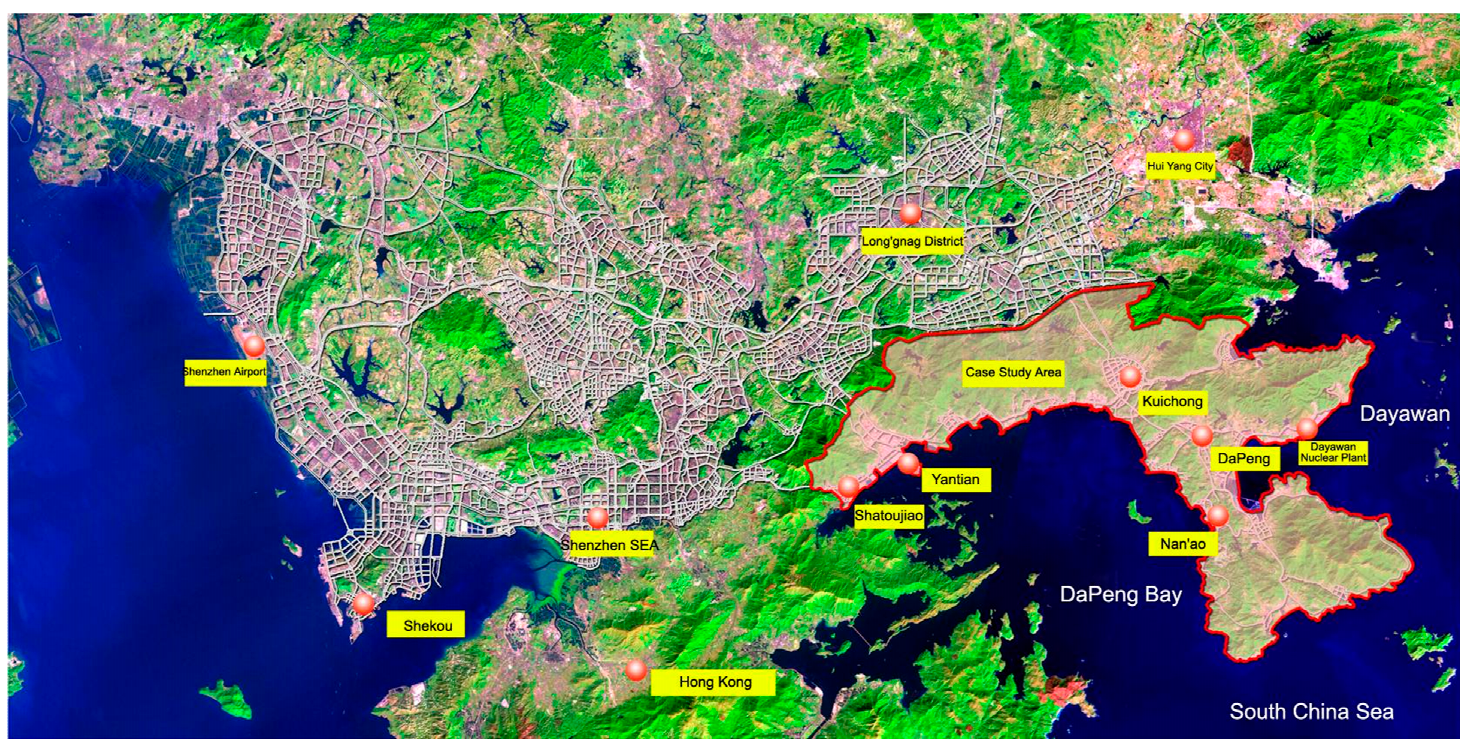
Figure 2. The Geographical Location of DaPeng Peninsula. (Source: The Development Plan of the Eastern Coastal Area of Shenzhen [44,45]).